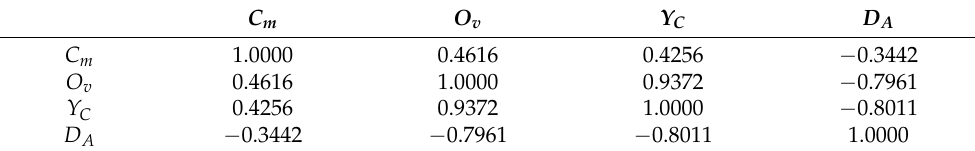
Table 4. Correlation between similarity indices and with genetic distance.